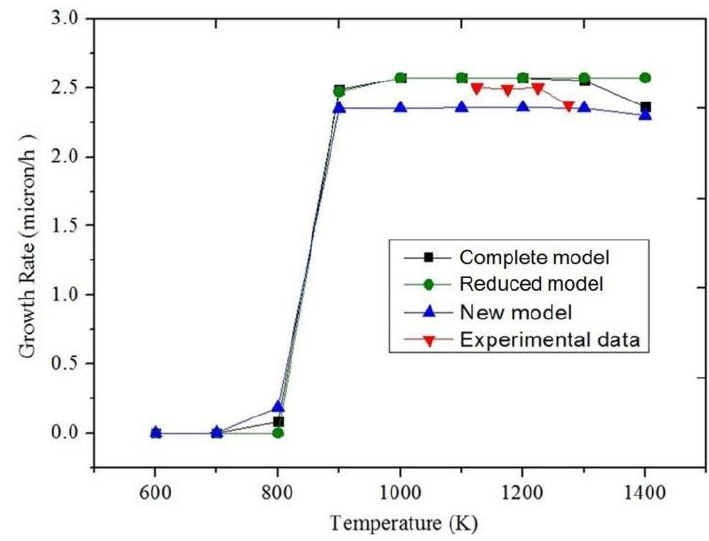
Figure 10. Comparison among all mechanism models.